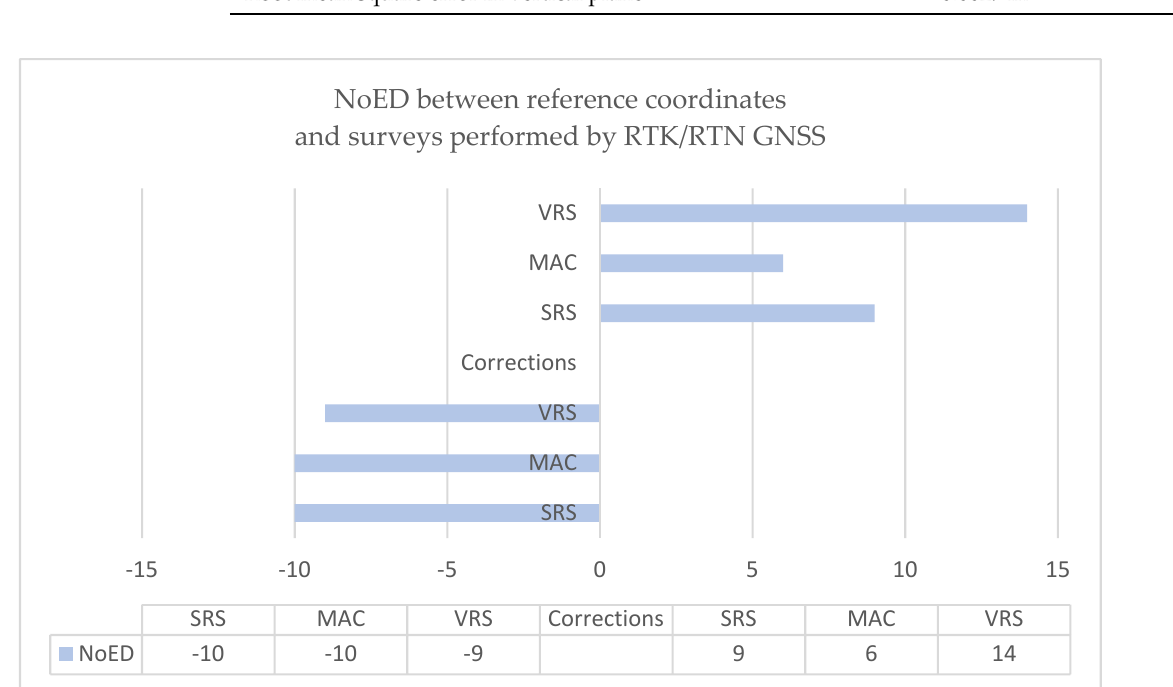
Figure 5. Number of maximum differences in positioning after applying GNSS static occupation and with use the individual type of corrections in RTK/RTN